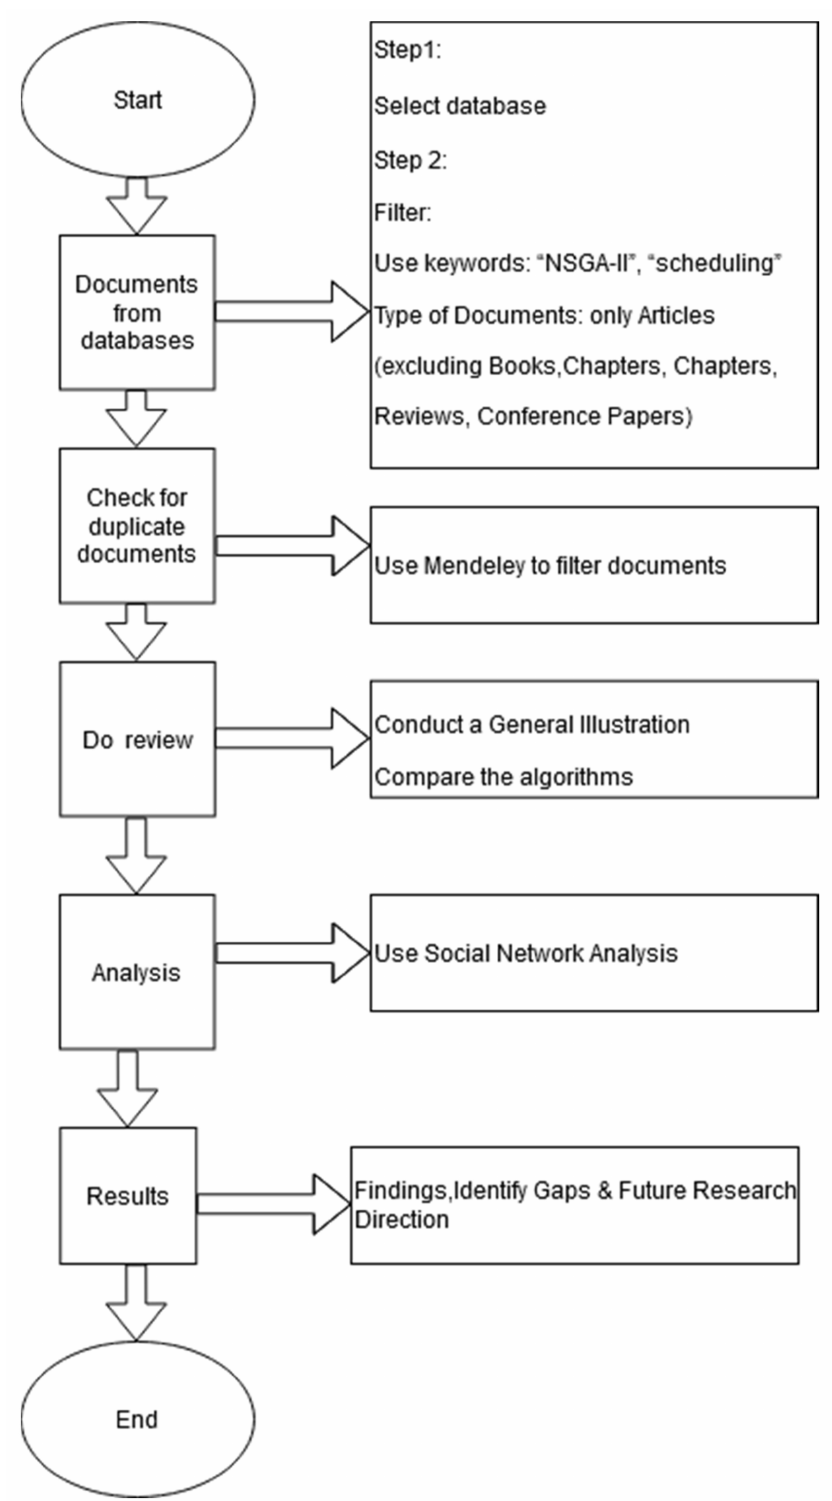
Figure 1. Research